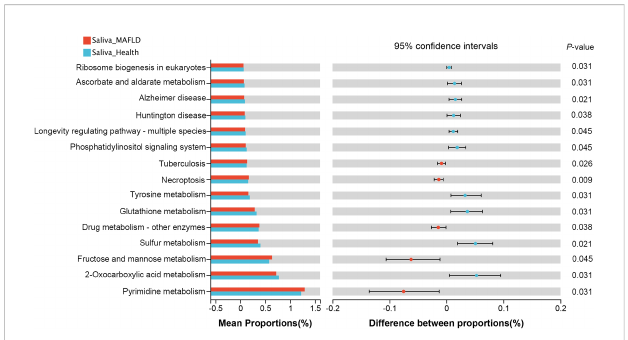
FIGURE 6 Predictive metagenome functional pro fi ling of the top 15 signi fi cantly abundant KEGG pathways using PICRUSt2 analysis. Bar plots on the left side show the mean proportion of each KEGG pathway; on the right display the differences between